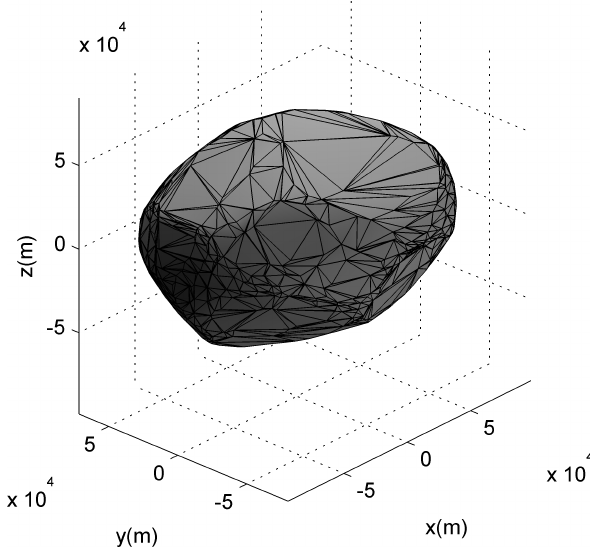
Figure 1. 3D ployhedron model of asteroid Kalliope, The shape was built by 2038 faces and 1021 vertexes.